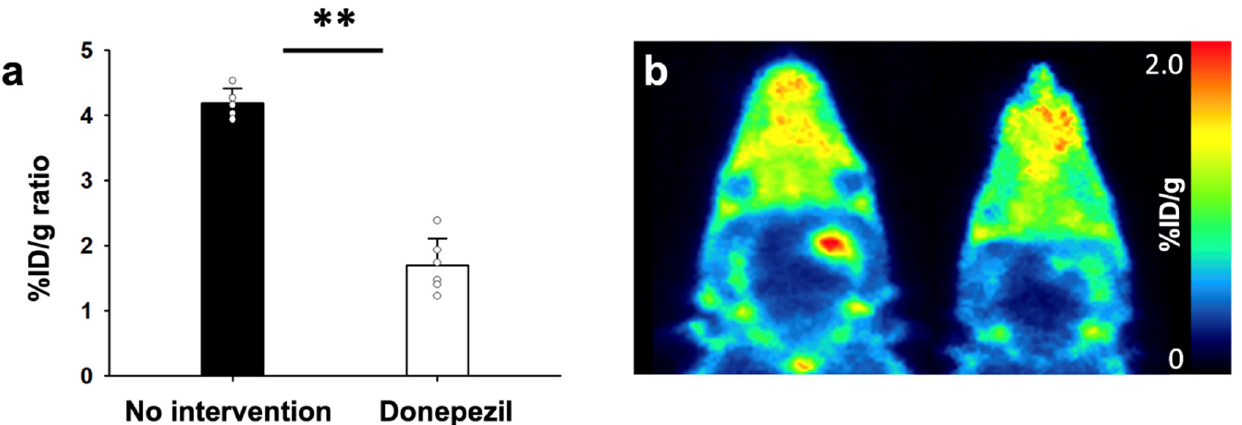
Figure 7. %ID/g ratios of [ 18 F]fluoromethyl-PBR28- d 2 ( 2 ) with, and without, donepezil treatment on day 11 after MCAO surgery ( a ). Representative TSPO PET images of respective conditions ( b ). The statistical significance of differences were determined using the Mann-Whitney U test; ** p < 0.01.